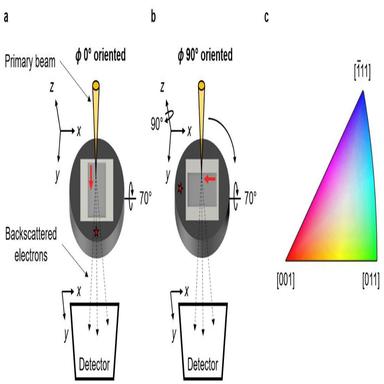
Sample orientations for EBSD data acquisition within the electron microscope. a) Primary beam oriented parallel (0° oriented) and b) perpendicular (90° oriented) to the feed direction (red arrow). c) Inverse pole figure (z) colouring used for all EBSD orientation maps.